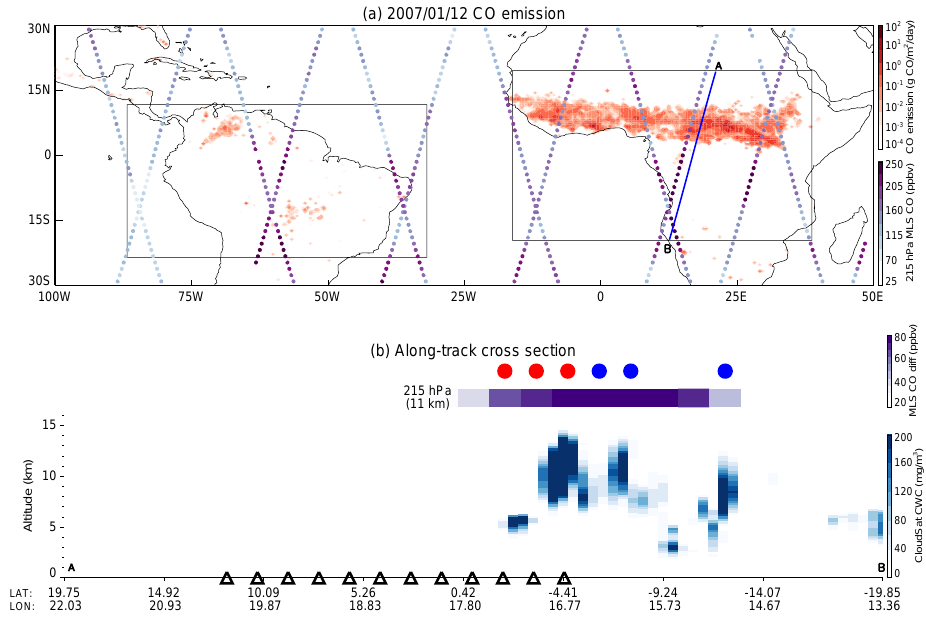
Fig. 2. (a) Spatial distributions of GFED3 surface CO emission and MLS instantaneous along-track measurements of CO concentration at 215hPa on 12 January 2007. The solid blue line indicates the CloudSat track parallel to the MLS track selected for the case study discussed in Sect. 3; the starting and ending points are indicated by A and B, respectively. The two selected analysis domains are outlined by the black box: South America (24 ◦ S–12 ◦ N, 88–32 ◦ W) and Central Africa (20 ◦ S–20 ◦ N, 16 ◦ W–40 ◦ E). (b) Vertical distributions of CloudSat CWC along the selected MLS track. Differences between observed CO volume mixing ratio and local monthly mean values at 215hPa greater than 20ppbv are shown in purple shading. The CloudSat CWC is from the original dataset, with the horizontal resolution reduced to ∼ 0.5 ◦ . The black triangles at the bottom indicate the presence of surface CO emissions along the cross section. The colored circles at the top indicate the CO transport pathways identified using the automated method, where red indicates “local convection” and blue indicates “LT advection →